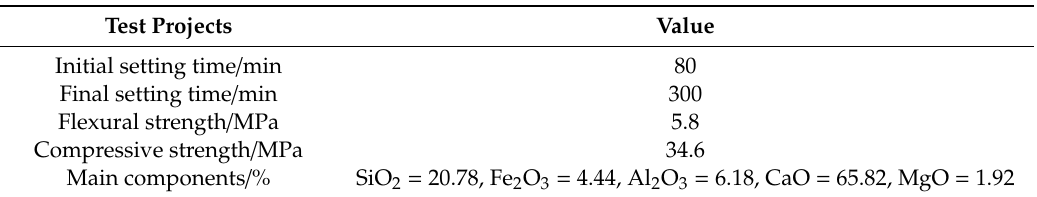
Table 1. Main physical characteristics of